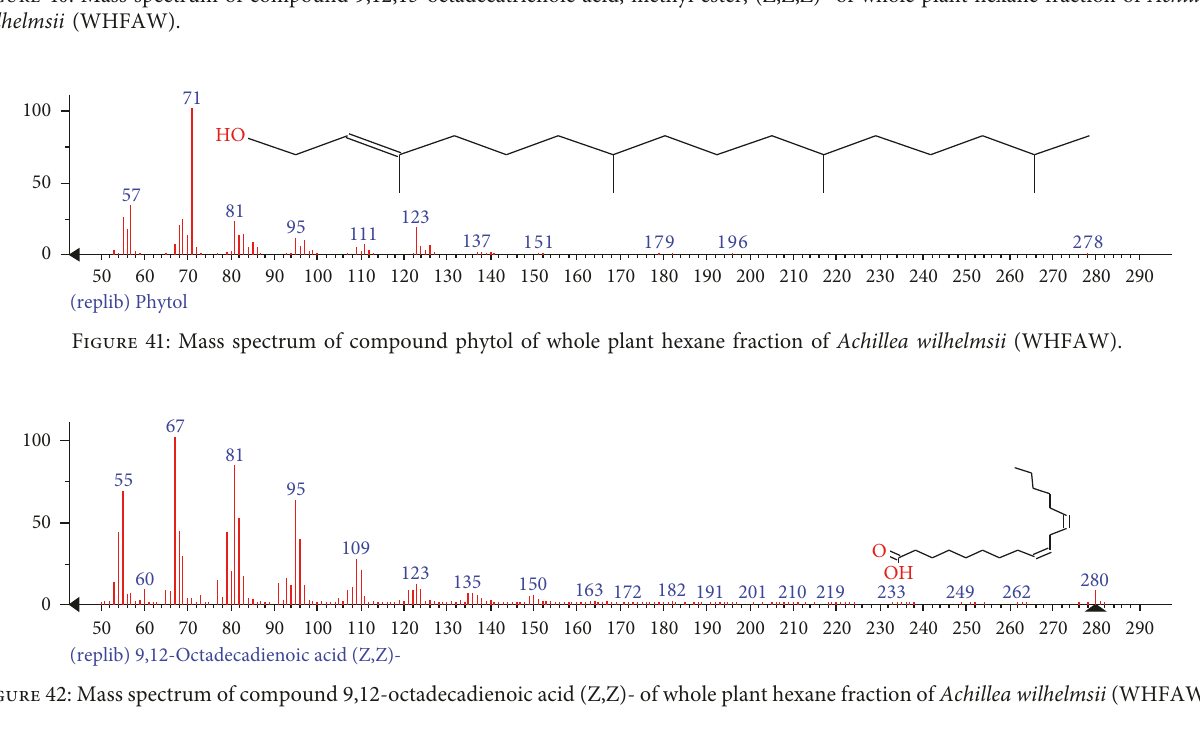
(Z,Z,Z)-50 60 (replib) 9,12,15-Octadecatrienoic acid, methyl ester, Figure 40: Mass spectrum of compound 9,12,15-octadecatrienoic acid, methyl ester, (Z,Z,Z)- of whole plant hexane fraction of Achillea wilhelmsii (WHFAW).